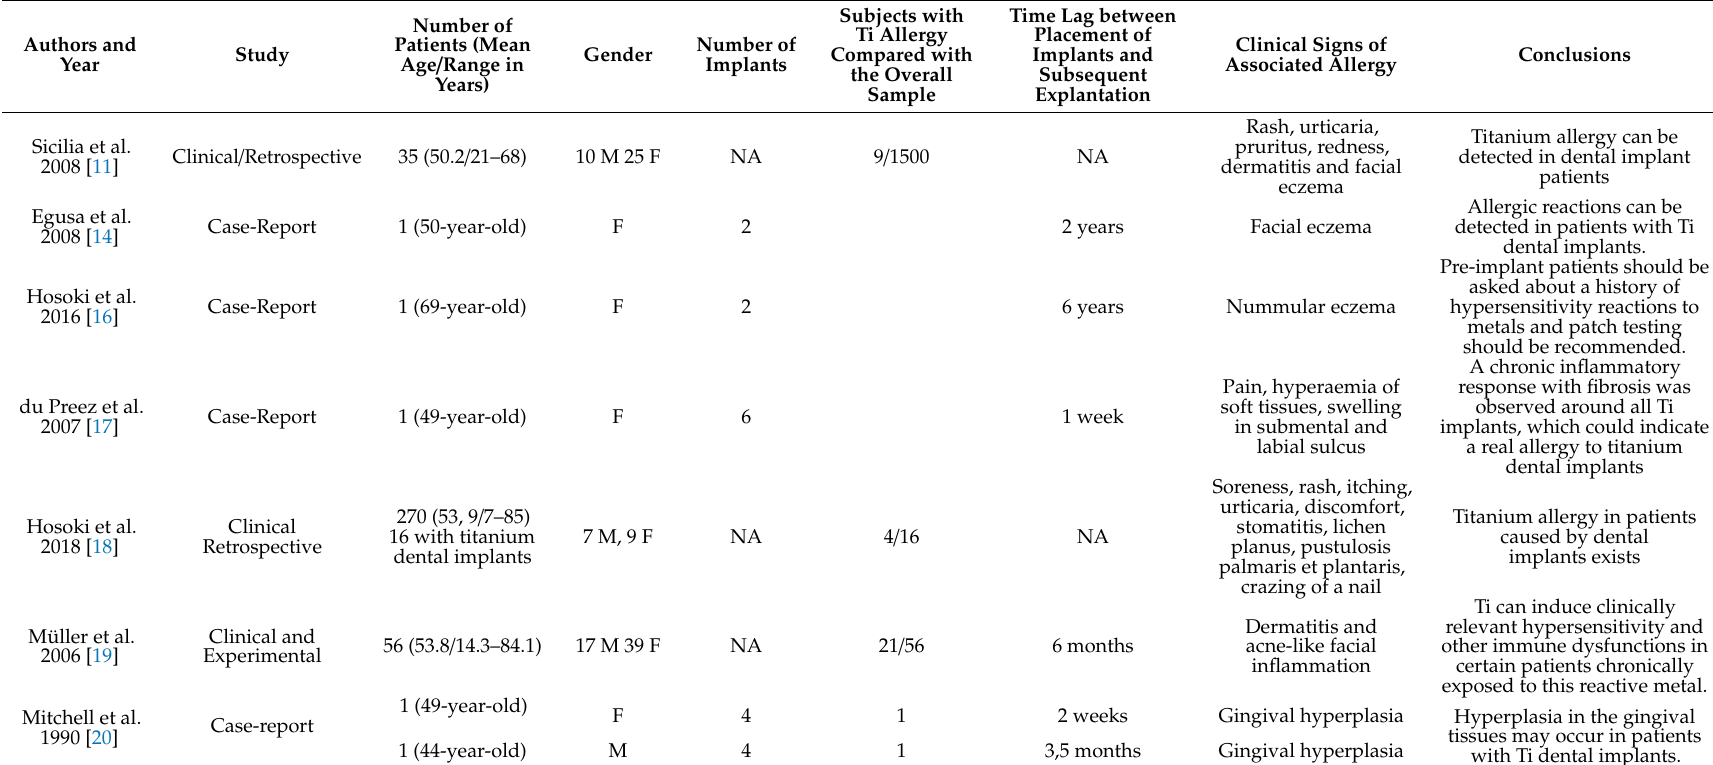
Table 1. Case Reports and Clinical Studies related to allergies to titanium dental